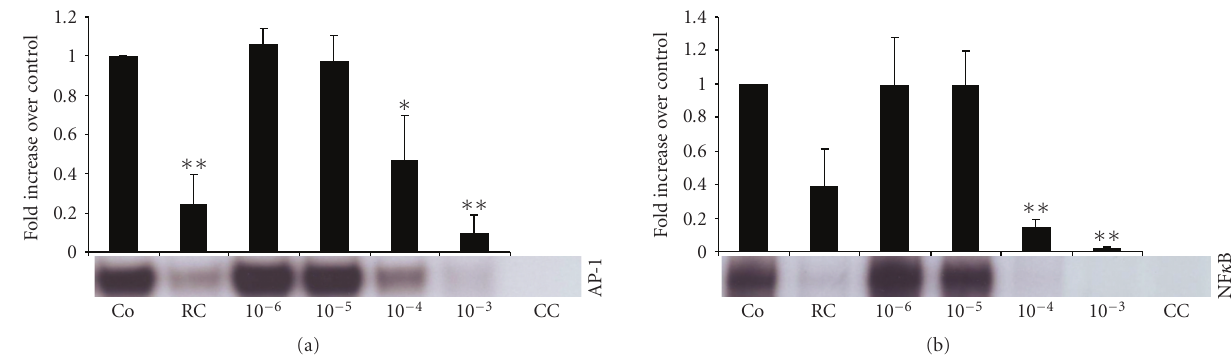
Figure 4: The main alkaloid compound of Rhizoma coptidis , berberine, inhibited binding activity of AP-1 (a) and NF κ B (b) in a concentration dependent fashion. Inhibitory potential of berberine was directly compared with the total extract of Rhizoma coptidis (dilution 1 : 5, incubation time 240 min). LPS-stimulated cells were incubated for 240 min. Berberine concentrations listed represent mol. AP-1: activated protein-1, NF κ B: nuclear factor κ B, Co: LPS-stimulated control cells, RC:Rhizoma coptidis , Be: berberine, and CC: cold competition. ∗ P < . 05, ∗∗ P < .